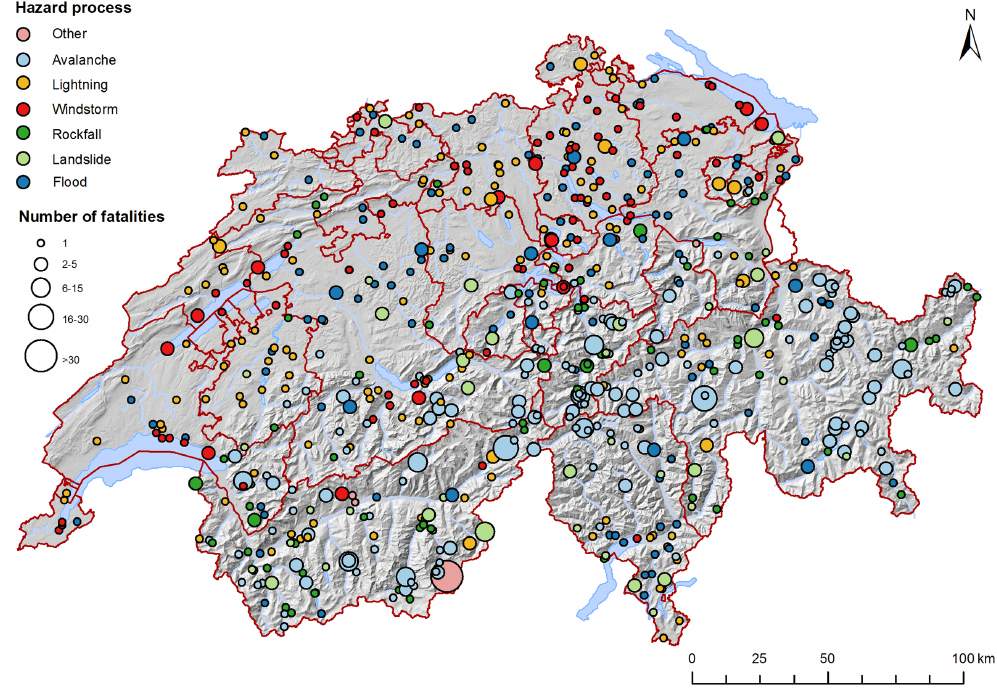
Figure 8. Spatial distribution of fatalities caused during natural hazard events in Switzerland from 1946 to 2015. The colour of each data point indicates the process category, and the size of the symbol shows the number of deaths per fatal accident (DHM source: dhm25 © 2016 swisstopo, 5704 000